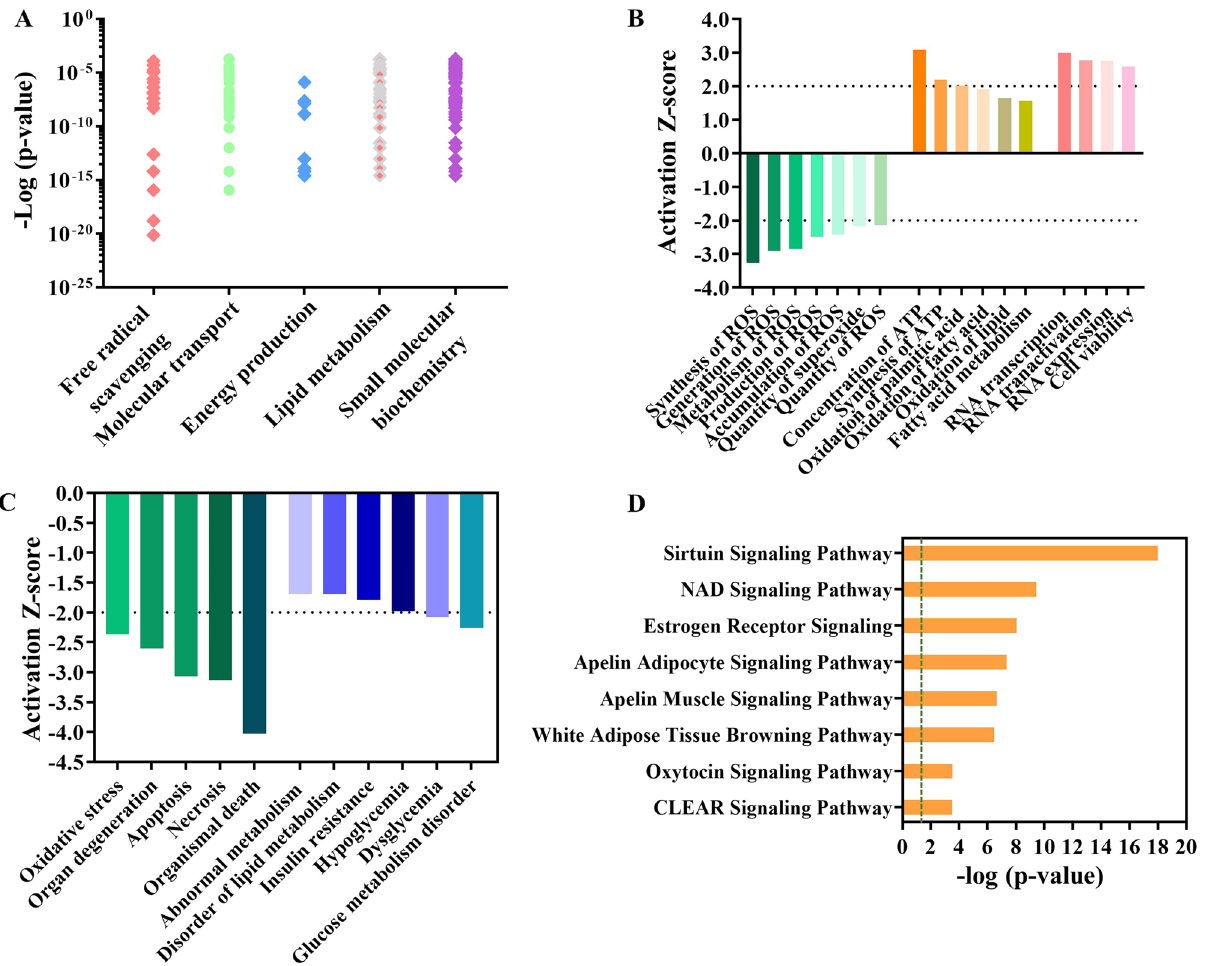
Figure 5. Ingenuity pathway analysis of the mRNA data. ( A ) The comparison of mRNA expression pattern in SAV1 KD cells to the ingenuity knowledge database revealed the top significantly upregulated molecular and cellular signatures in SAV1 KD myoblasts. Right-tailed Fisher’s exact test; p < 0.05 was considered statistically significant. ( B ) The over-represented biological functions in SAV1 KD cells included reduced reactive oxygen species (ROS) synthesis and increased energy production, RNA transcription, and cell viability. The Z score was used to calculate the data interpretation. Z-score ≥ 2.0 (activation) and Z-score ≤ -2.0 (inhibition). The gray dash line indicates the threshold of significance. ( C ) SAV1 KD was predicted to downregulate organism death, oxidative stress, and metabolic disorders. Z-score ≥ 2.0 (activation) and Z-score ≤ -2.0 (inhibition). ( D ) The top upregulated canonical pathways in SAV1 KD cells. Right-tailed Fisher’s exact test; green dash line indicating the threshold p value (p =